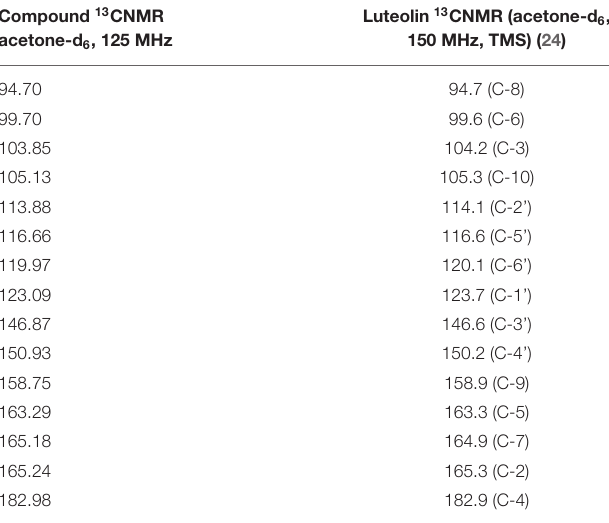
TABLE 5 | The 13 C NMR spectral data of luteolin isolated from S. singueana . Compound 13